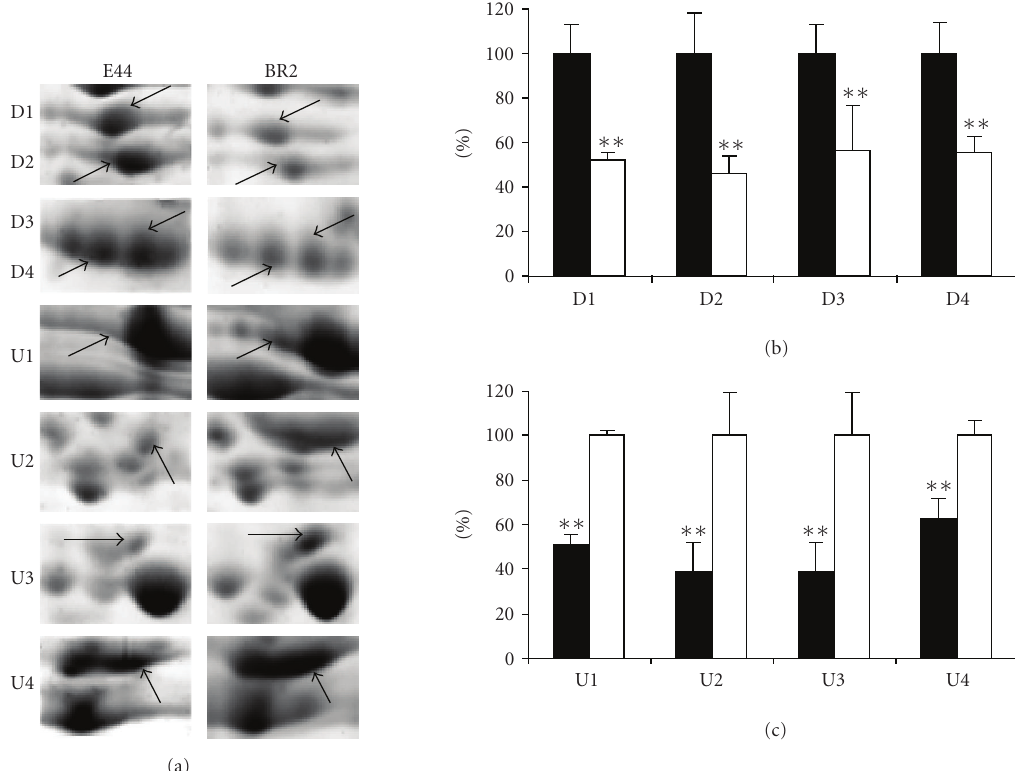
Figure 3: Comparative analysis of the protein spots showing significant changes . (a) Enlargement of di ff erentially expressed protein spots (indicated with arrows) from Figure 2. (b) The relative level of down-regulated proteins. (c) The relative level of up-regulated proteins. The protein spot intensities of E44 were showed as black columns, and the protein spot intensities of BR2 were showed as white columns. Columns marked with ∗∗ are significantly di ff erent ( P < 0 .